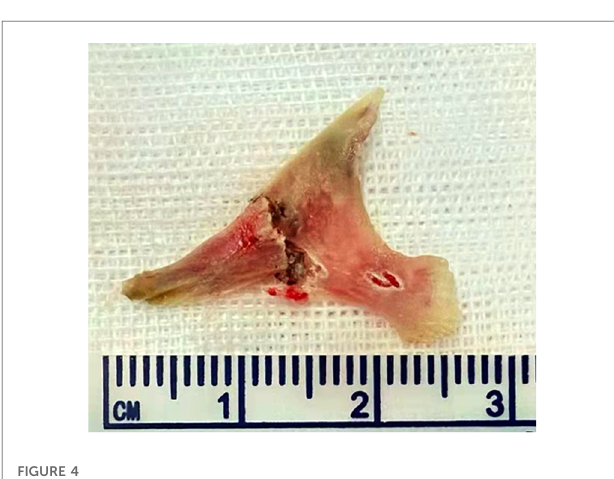
FIGURE 4 The fi shbone was removed after being broken by the holmium